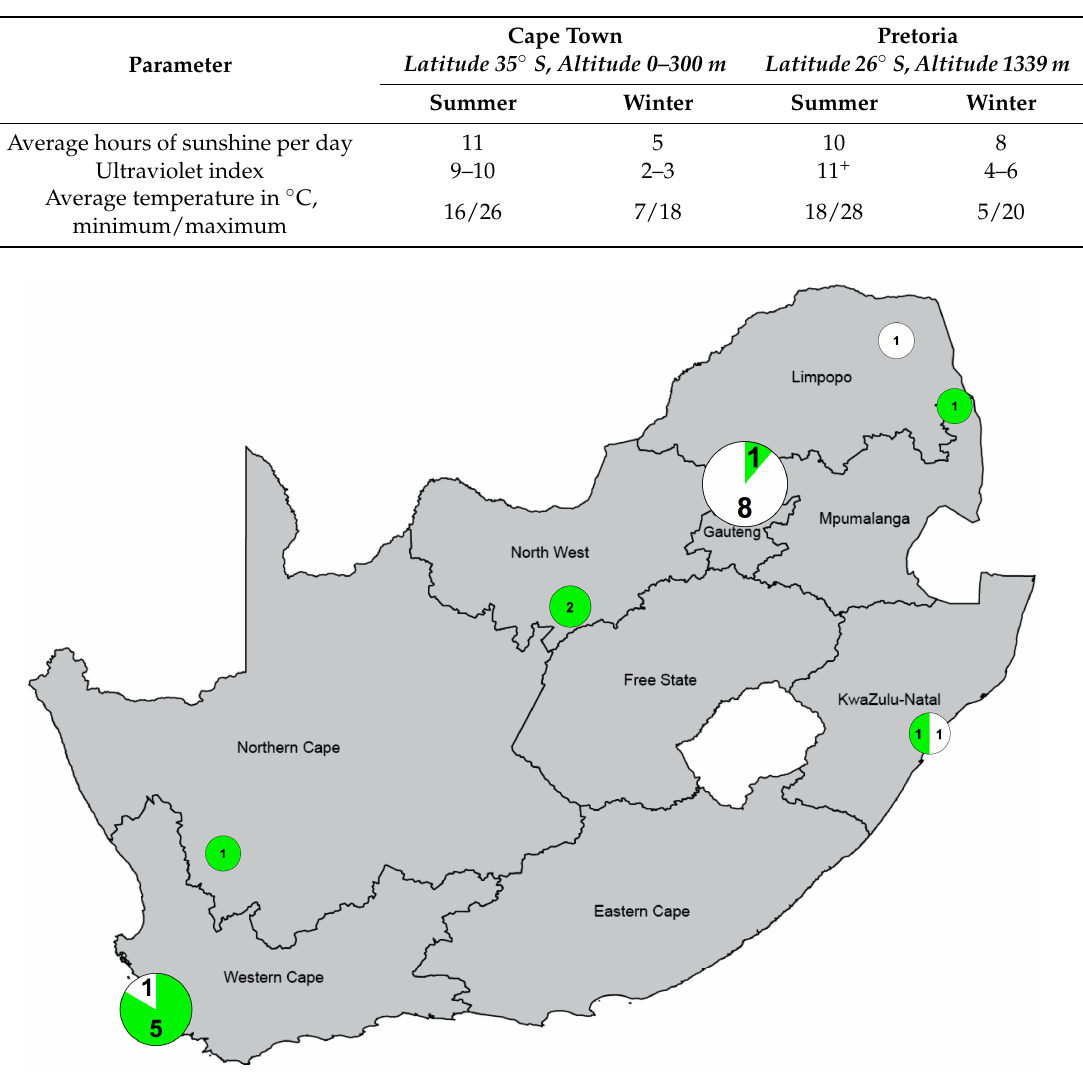
Table 1. Weather conditions in Cape Town and Pretoria; data from [16–18].